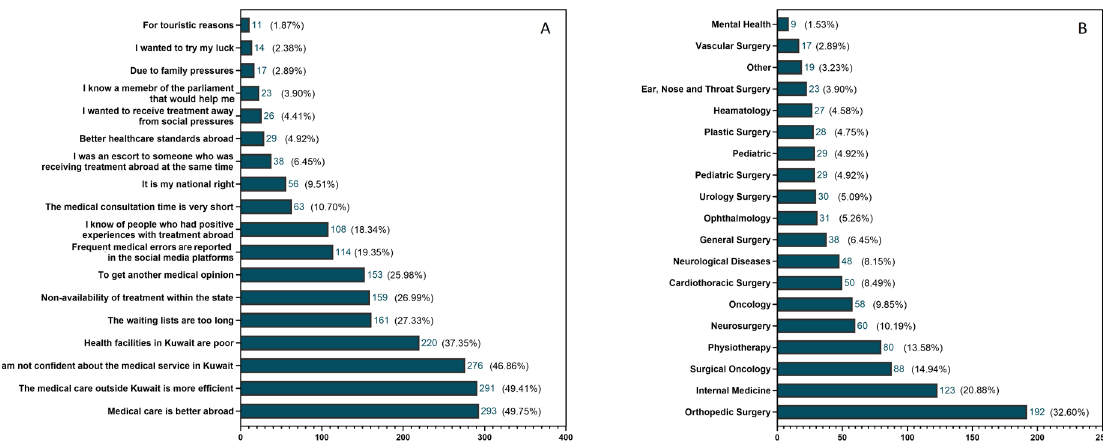
Figure 1. Reasons for Seeking Treatment Abroad (A) and Type of Medical Conditions (B) - Only responses with n > 10 are shown; % were calculated from the total sample size (n =